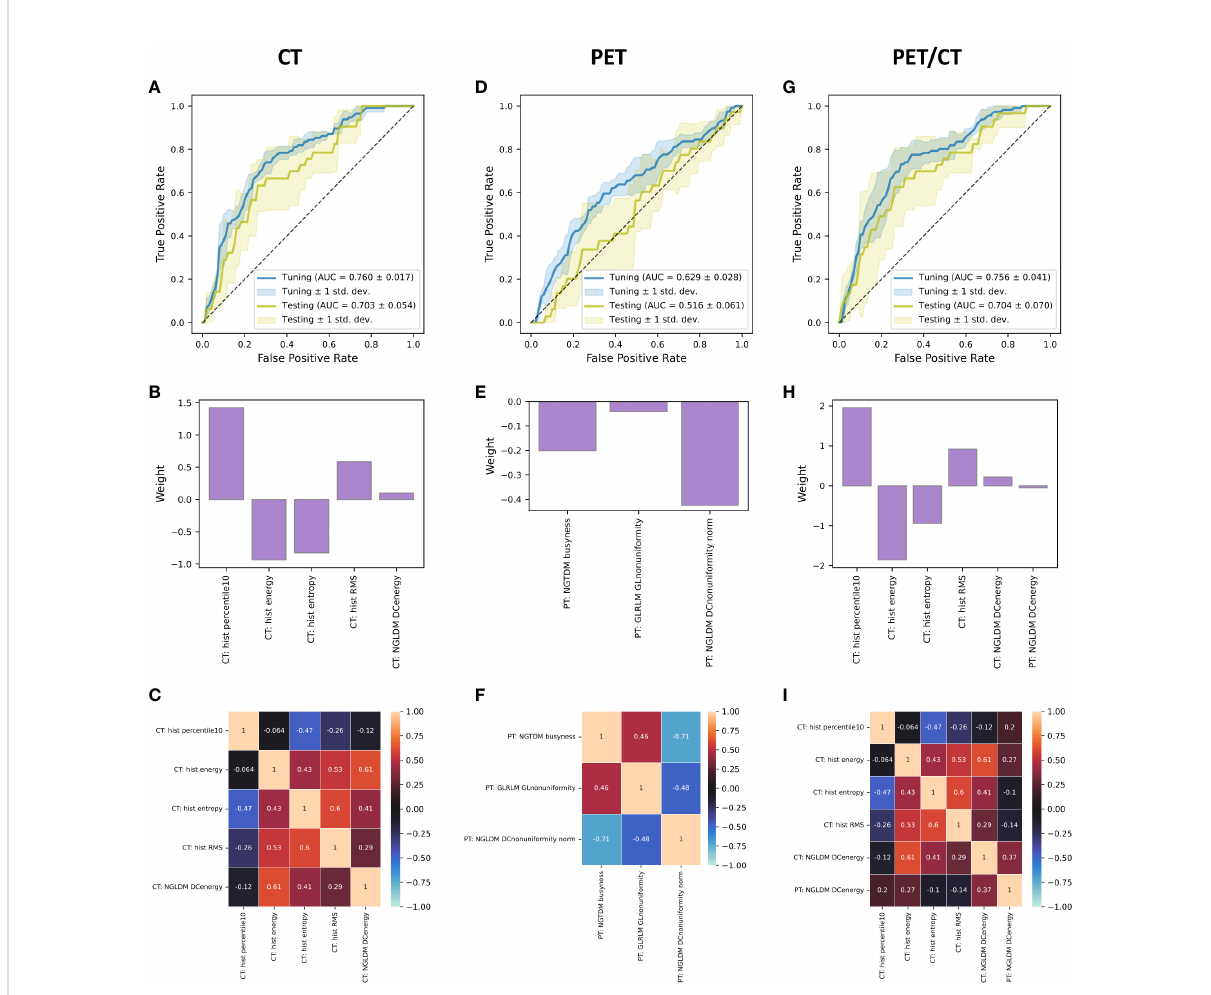
FIGURE 4 Receiver operating characteristic curves (A, D, G) , feature weights (B, E, H) , and correlation matrices with Kendall ’ s tau (C, F, I) for the CT-, PET-, and PET/CT-based logistic regression models predicting HPL at three months after start of treatment. The receiver operating characteristic curves were calculated for each fold of cross-validation and the curves presented in the fi gure are result of averaging of the component curves. Python code used for generation of these fi gures is provided in a public online repository (https://github.com/hubertgabrys/PET-CT-radiomics-